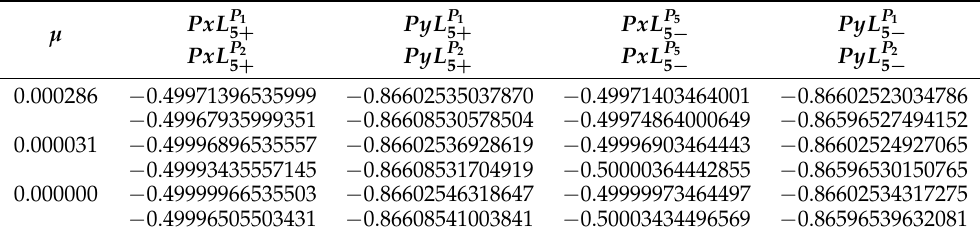
Table 13. Perpendicular equilibrium solution near L 5 of different planetary